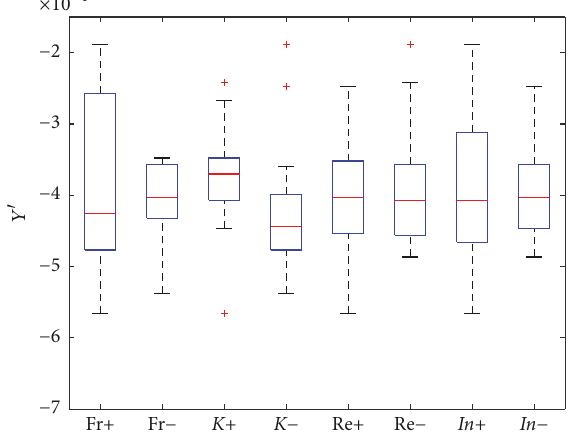
Figure 16: Boxplot of the 𝑌 󸀠 position at 𝑋 󸀠 = 1.125×10 −3 for a plate with a starting negative angle